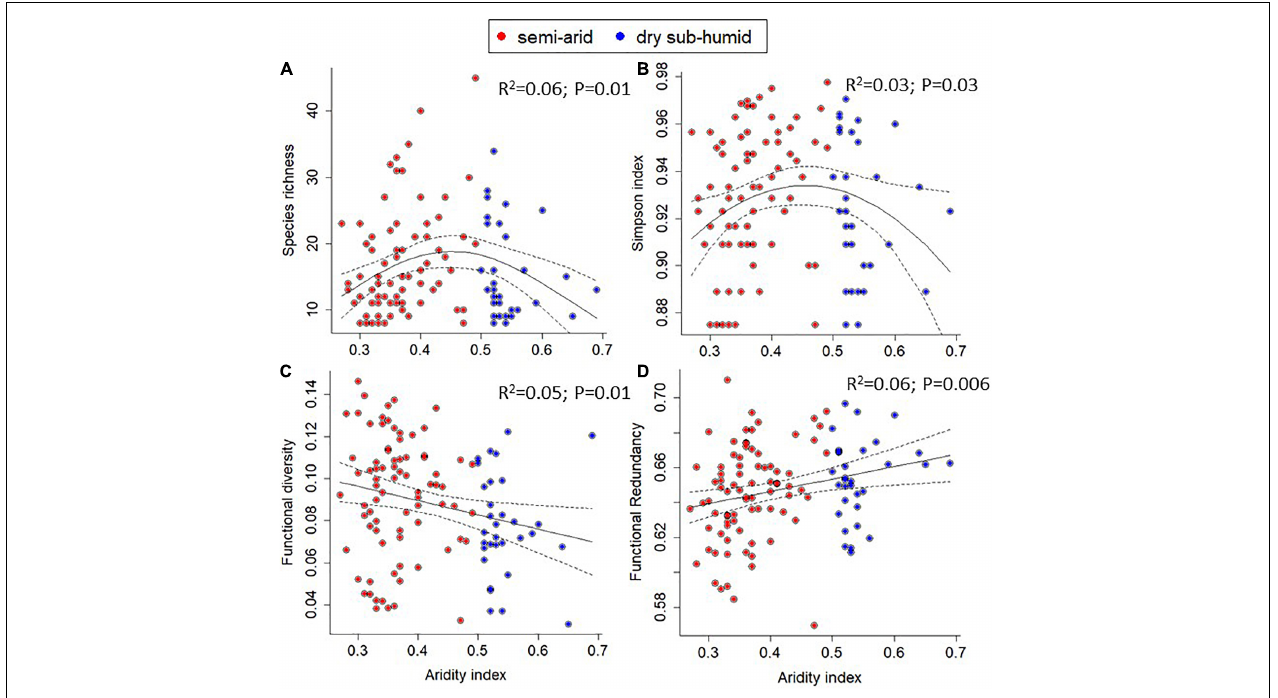
FIGURE 2 | Relationships between the aridity index and: (A) species richness; (B) Simpson diversity index; (C) functional diversity; and (D) functional redundancy. Solid and dashed lines represent the fitted linear or quadratic regression and 95% confidence intervals, respectively. Adjusted R 2 and associated p -values are also